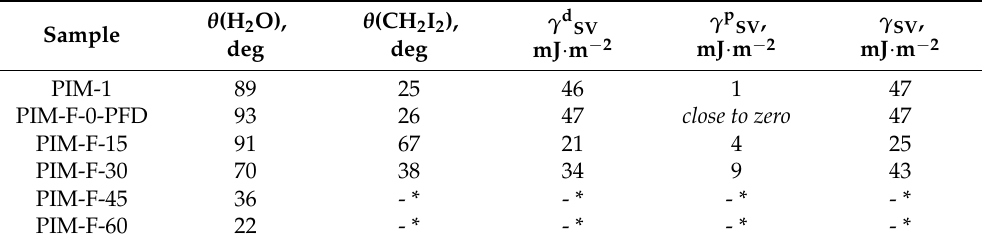
Table 3. Changes in the characteristics of the surface of PIM-1 films depending on the conditions of